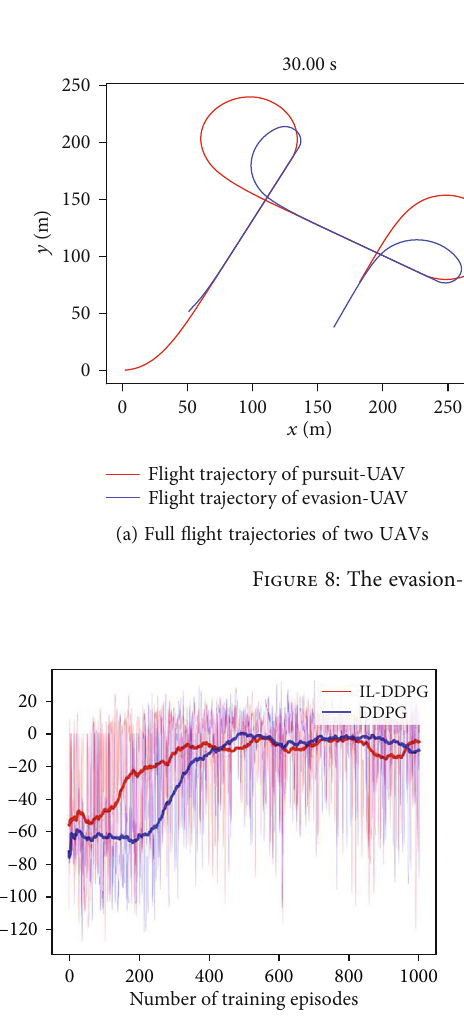
Figure 9: Average rewards of IL-DDPG and DDPG algorithm (the thin line of the background is the real-time curve of the total reward per episode, and the thick line is the average reward curve per